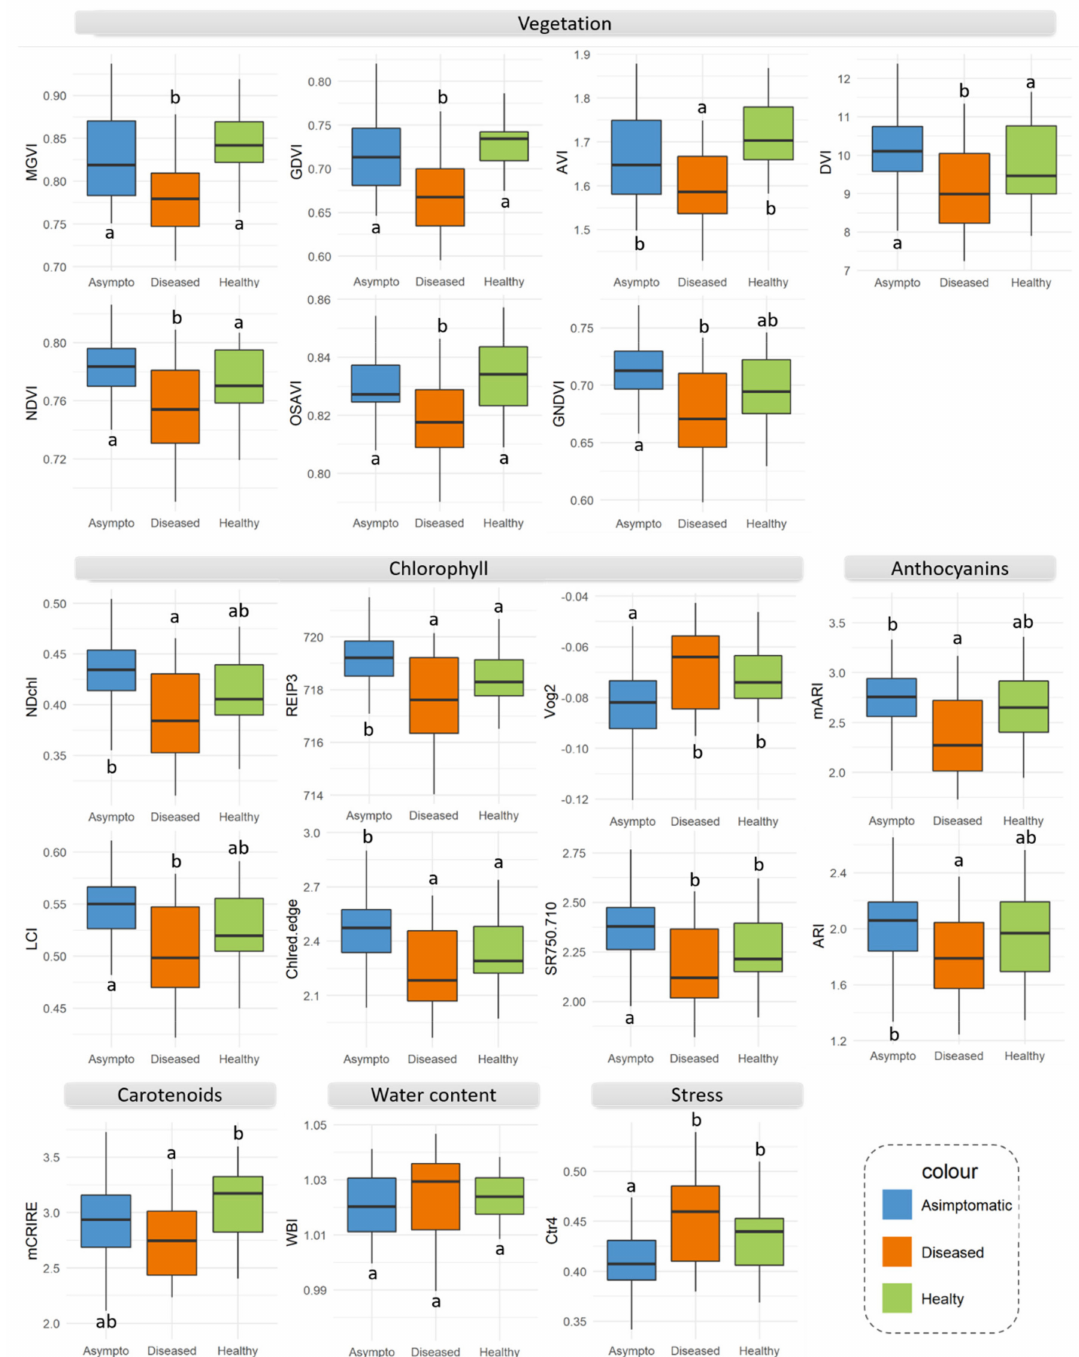
Figure 10. Vegetation indices values in sort of box plots with their quantiles, mean, and maximum. Within each single vegetation index, plant groups are identified by different colors and classified with letters as a result of the Tukey (HSD) cross-validation test ( p -value <